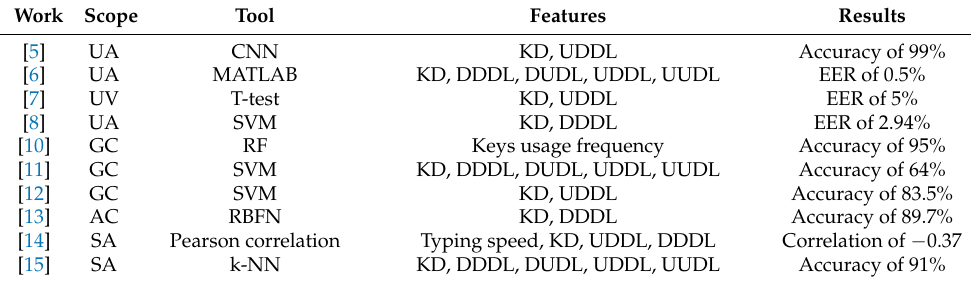
Table 1. Summary of related works. (UA—User Authentication; UV—User Verification; GC— Gender Classification; AC—Age Classification; SA—State Assessment; CNN—Convolutional Neural Network; SVM—Support Vector Machine; RF—Random Forest; RBFN—Radial Basis Function Network; k-NN—k Nearest Neighbor; KD—Keystroke Durations; DDDL—down-down diagram latencies; DUDL—down-up; UDDL—up-down; UUDL—up-up; EER—Equal Error Rate).